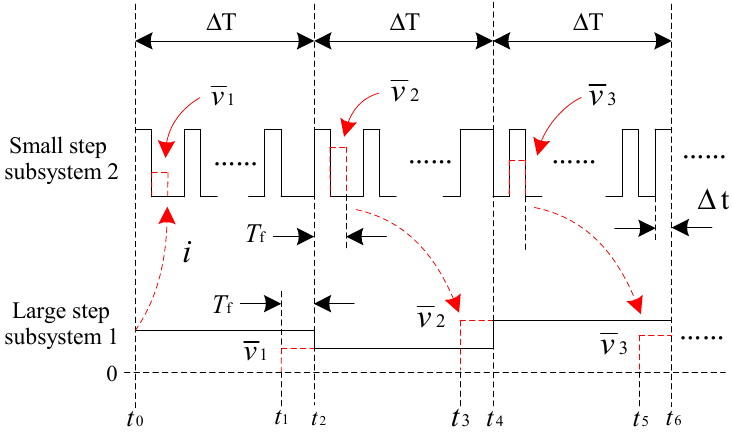
Figure 6. Large-step data delay schematic.